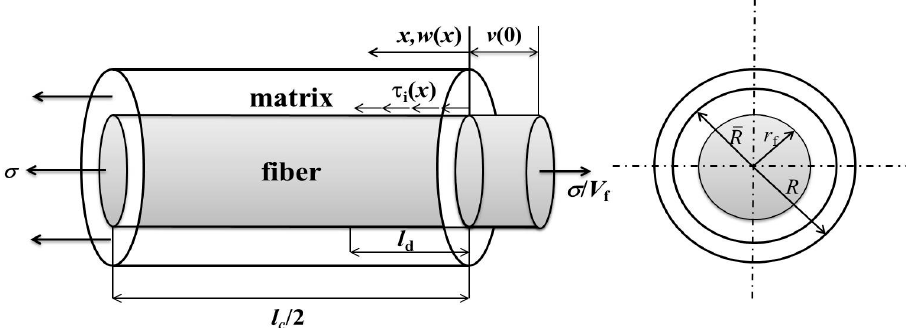
Figure 1. The unit cell of the Budiansky–Hutchinson–Evans shear-lag model.